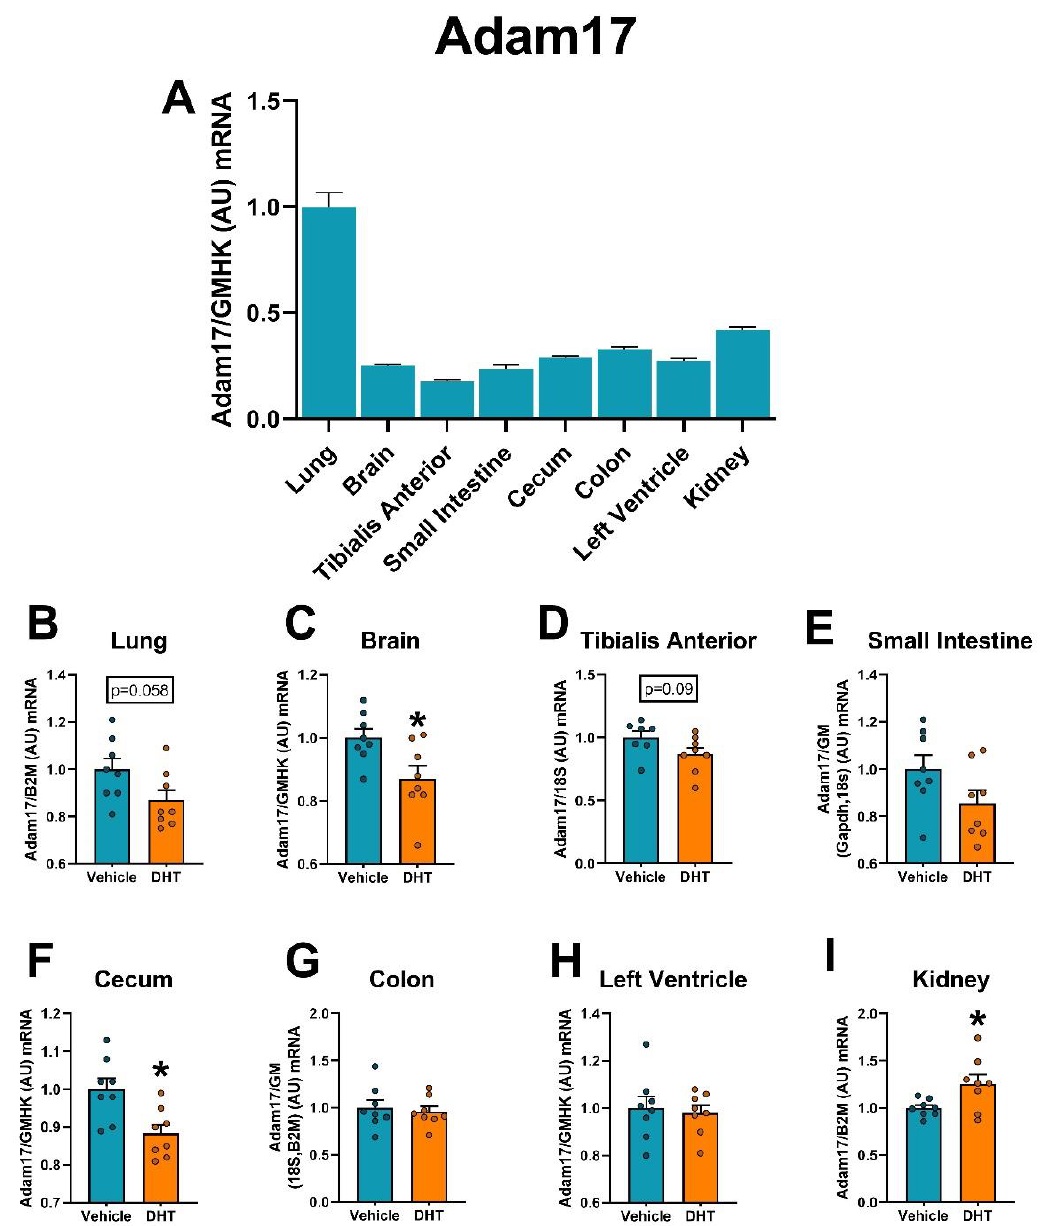
Figure 11. Adam17 mRNA expression regulation by DHT in different tissues. Adam17 mRNA expression was quantified by RT-qPCR. ( A ) Adam17 mRNA expression in control mice normalized to the geometric mean of all reference genes and expressed relative to lung tissue. ( B – I ) Adam17 mRNA expression in the lung ( B ), brain ( C ), tibialis anterior ( D ), small intestine ( E ), cecum ( F ), colon ( G ), left ventricle ( H ), and kidney ( I ) of control and DHT-treated mice normalized to the least variable reference gene or set of them, and expressed relative to control mice. Data analyzed by t -test. n = 7–8/group. *: p < 0.05.